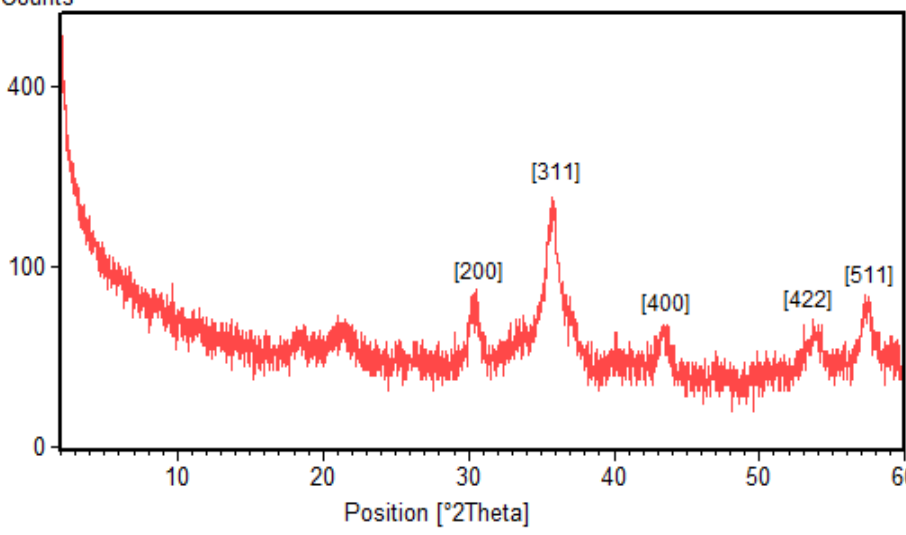
Figure 3. XRD pattern of Fe